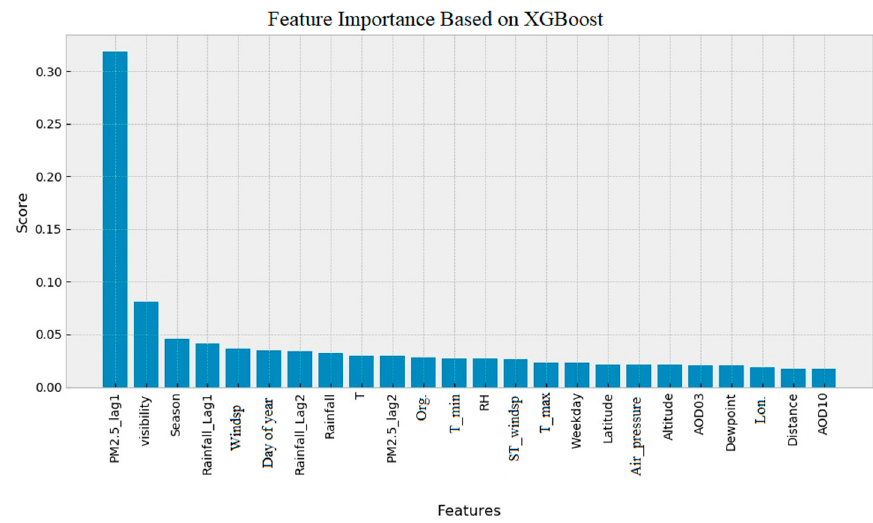
Figure 6. Feature importance bar graph based on random forest modeling.